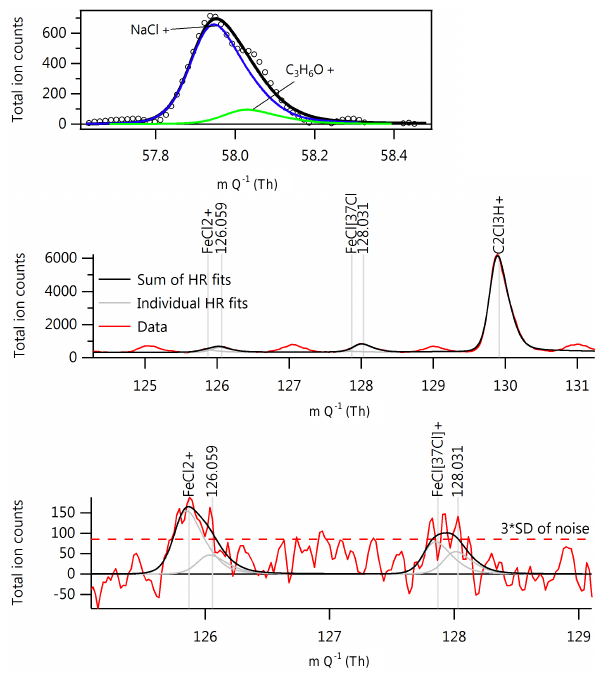
Figure 10. Top: Isobaric peaks of NaCl + and C 3 H 6 O + . Centre: total mass spectrum showing the calibrant ion C 2 Cl 3 H + and sig- nals from unknown compounds at nominal masses 126 and 128Th. Bottom: difference mass spectrum (ambient minus filter) show- ing statistically relevant signals from the isotopes Fe 35 Cl + Fe 37 Cl 35 Cl + .